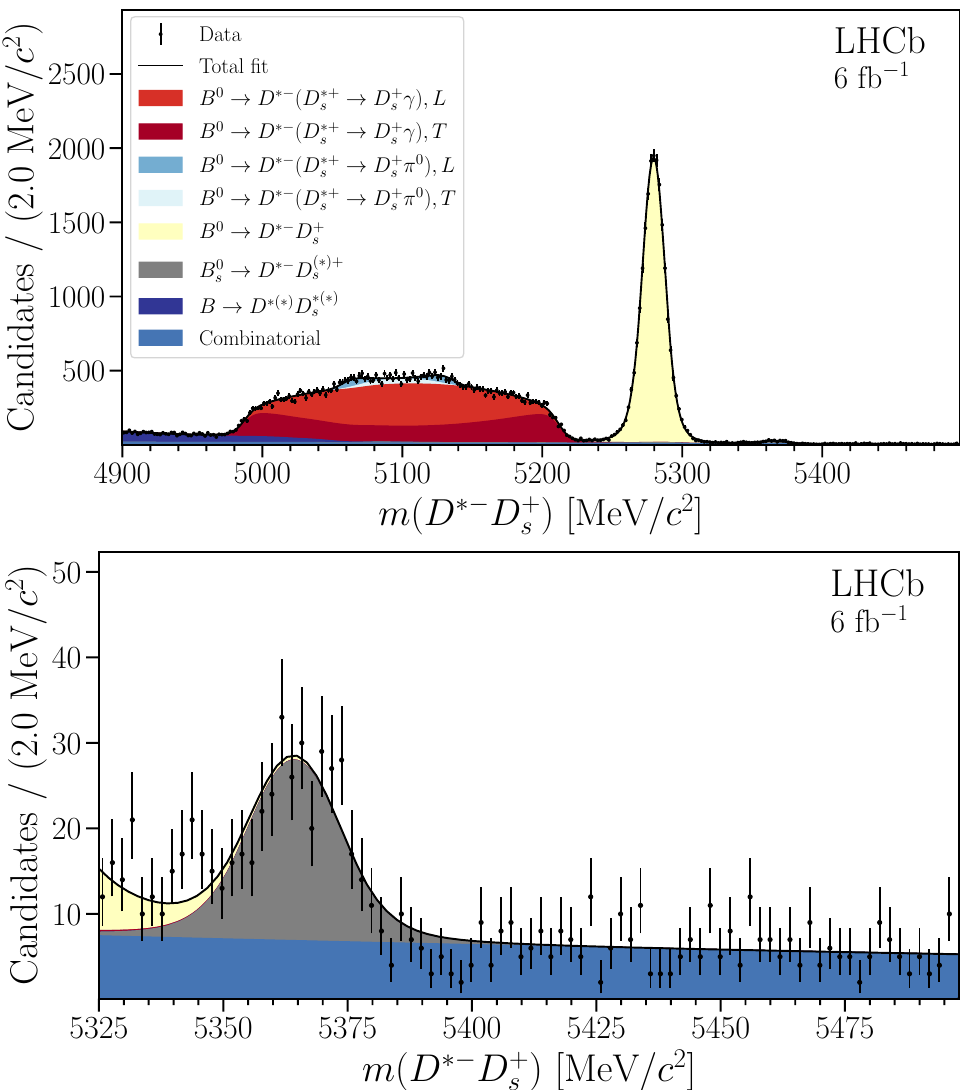
) for selected candidates in data, with the fit overlaid. Figure 2 . (Top) Distribution of m ( D ∗− D + s Where indicated, L ( T ) represents longitudinally (transverse) polarised decays. (Bottom) Re- stricted to region for candidates with m ( D ∗− D + ) > 5325 MeV/ c 2 , where the Cabibbo-suppressed s contribution is B 0 → D ∗− D + s s